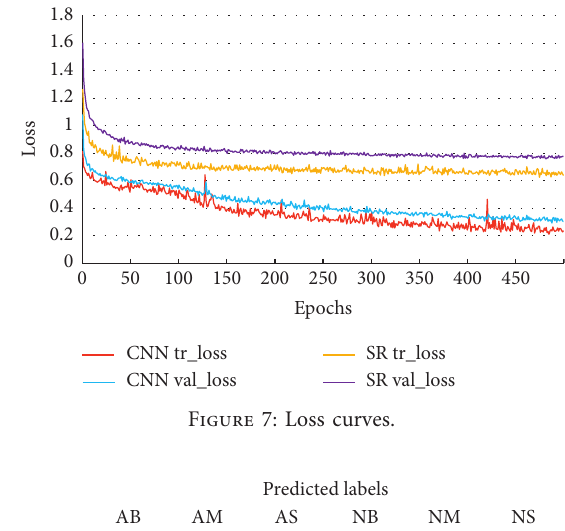
Figure 7: Loss curves.